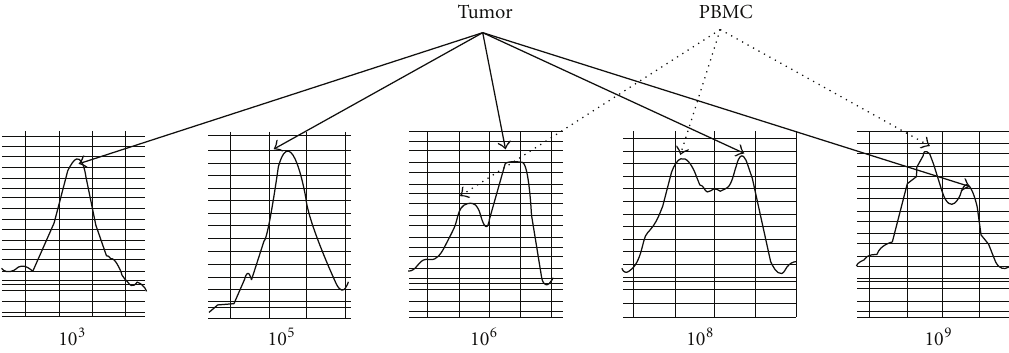
Figure 2: MRD sensitivity with patient primary tumor DNA. Primary diagnostic tumor DNA (100% infiltrated with malignant cells) was diluted with PBMC DNA to represent the equivalent of 1 malignant cell in 10 3 , 10 5 , 10 7 , 10 8 , and 10 9 PBMC. Each representative melt curve has a distinct peak corresponding to tumor DNA or PBMC DNA, which are designated by the respective